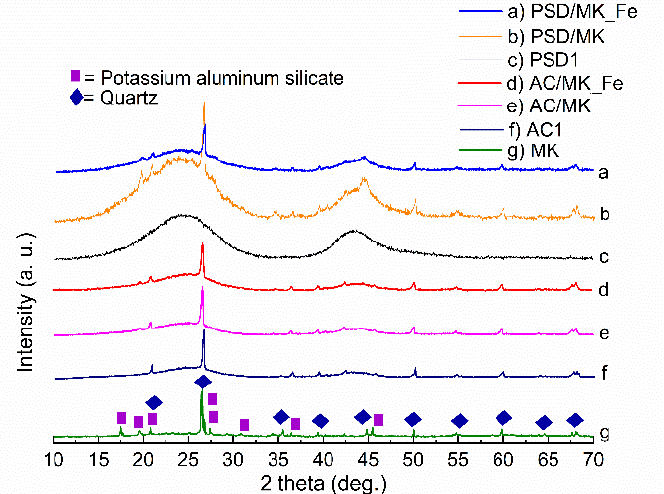
Figure 1. X-ray diffractograms of the studied materials. The crystalline phases marked to the MK diffractogram are identified as SiO 2 (ICDD: 01-070-7344) and KAl 3 Si 3 O 11 (ICDD: 00-046-0741).